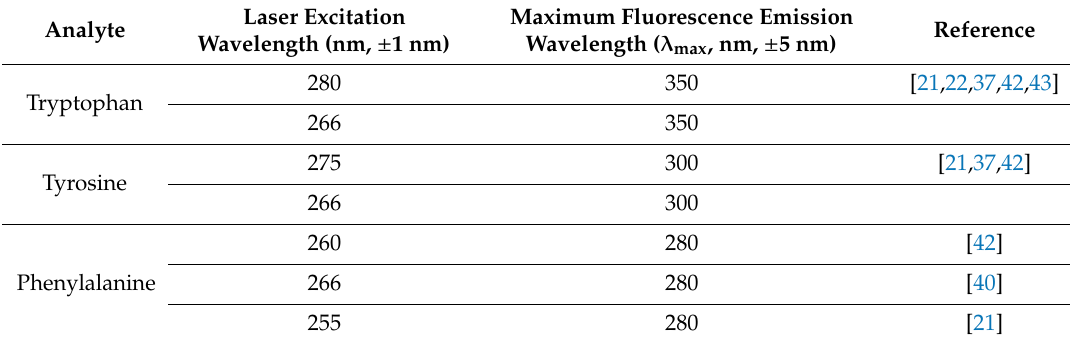
Figure 4. Fluorescence of three aromatic amino acids excited by a UV laser at 266 nm. Tryptophan fluoresced to a maximum of 350 nm, tyrosine to a maximum of 300 nm, and phenylalanine to a maximum of 280 nm. Table 1. Emission maxima of fluorescence spectra of aromatic amino acids [21,37,42,43].